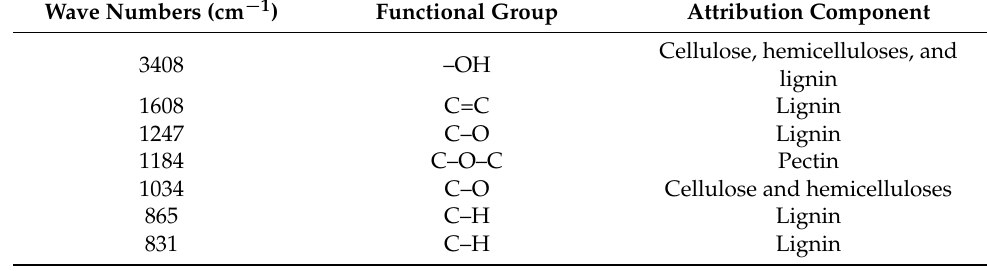
Figure 5. FTIR spectra of flax fiber at ( a ) room temperature, ( b ) 120 ◦ C, ( c ) 140 ◦ C, ( d ) 160 ◦ C, ( e ) 180 ◦ C ( f ) 200 ◦ C. Table 2. Characteristic bands of the infrared spectra of flax fiber.